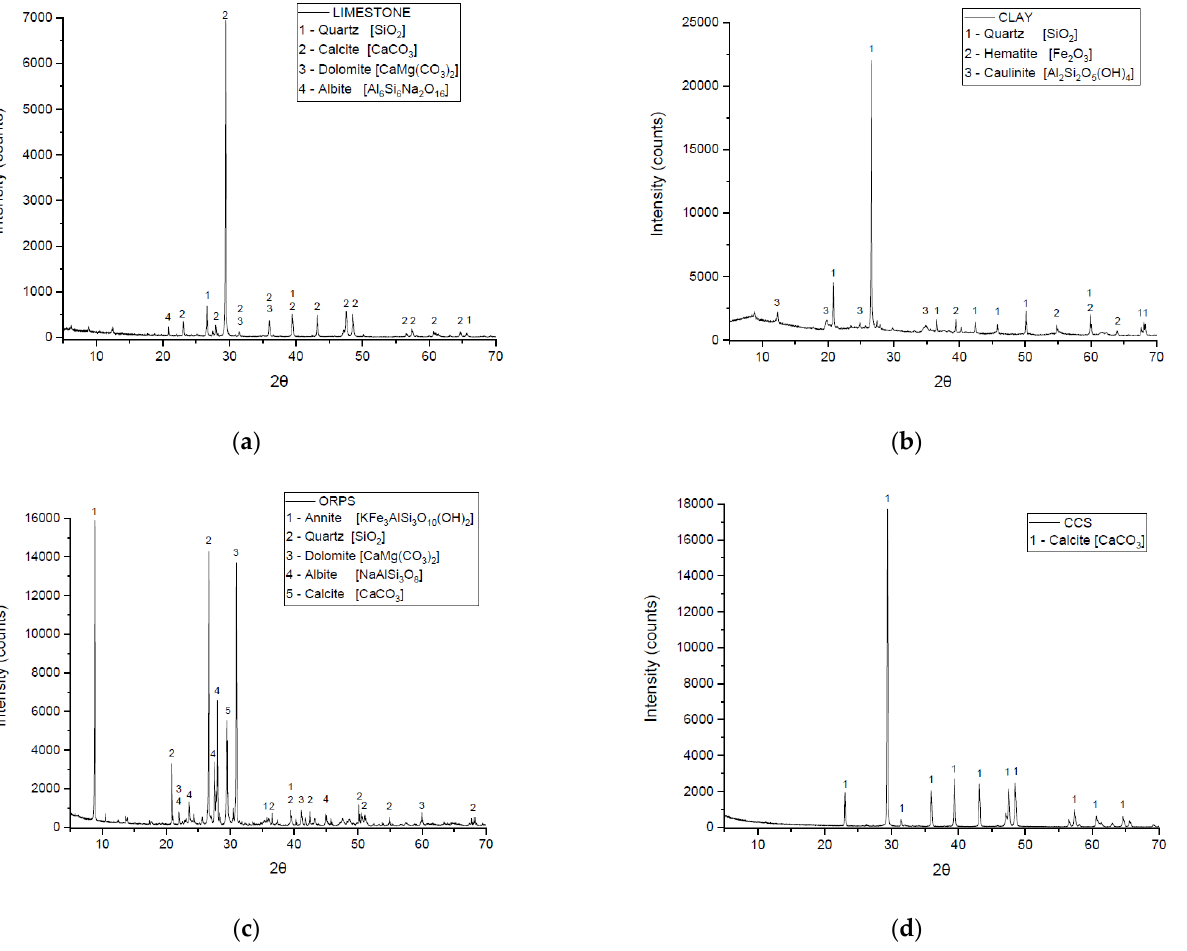
Figure 4. Mineral characterization of the raw materials. Limestone ( a ), Clay ( b ), ORPS ( c ), and CCS ( d ).